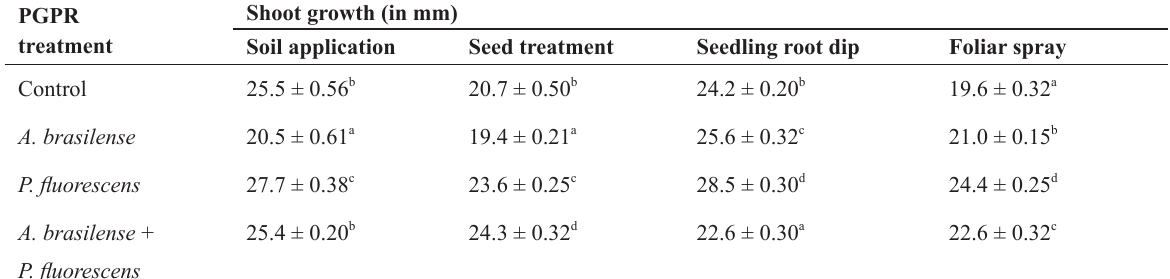
Effect of methods of application of single and mixed PGPR on the shoot growth of groundnut plants.